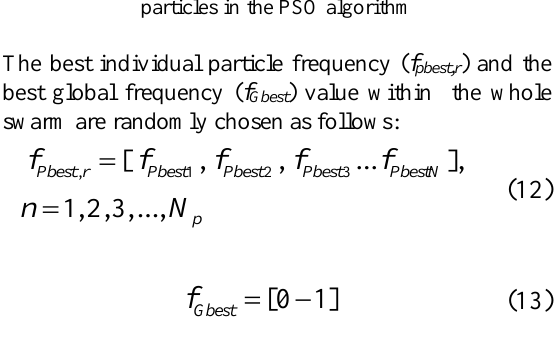
Figure 3. The vectorial movement of frequency-based particles in the PSO algorithm